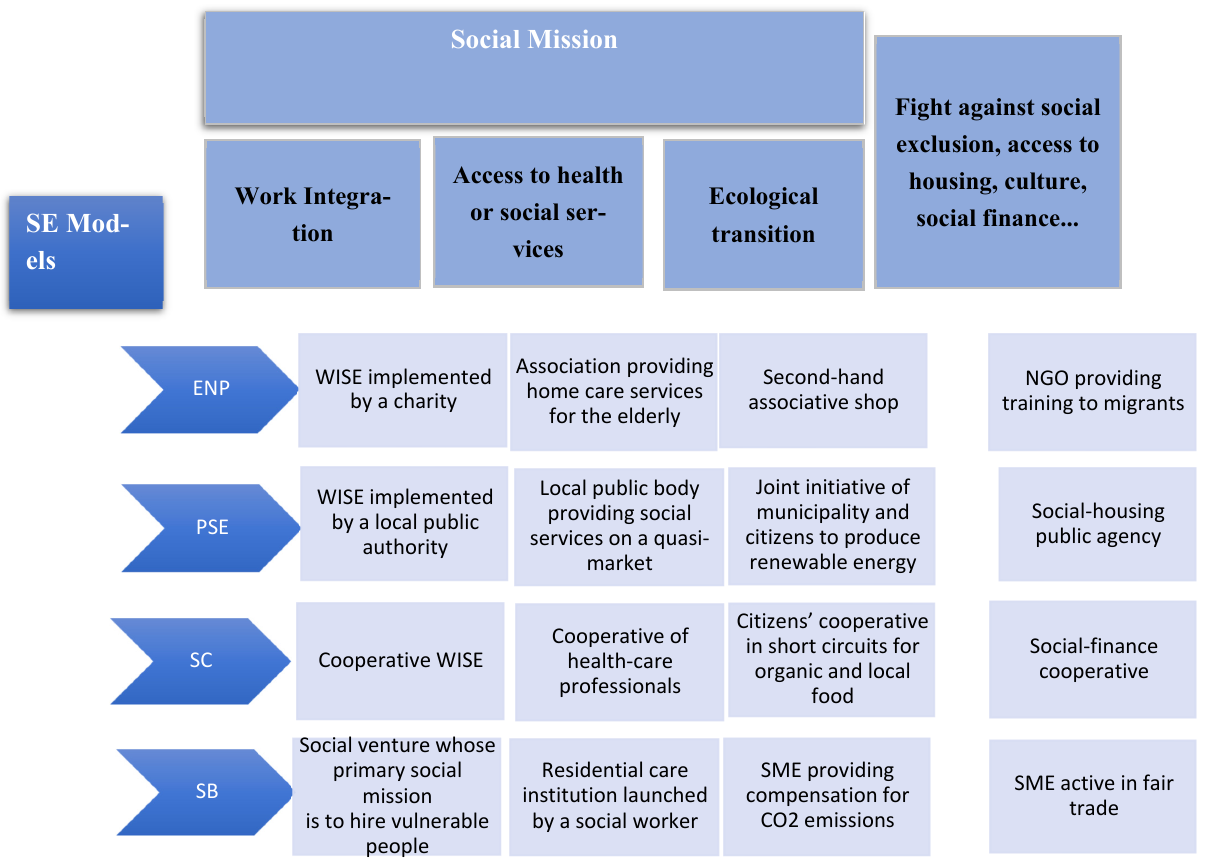
Figure 3. Social Enterprise Models and Social Mission. Source: Based on (Defourny et al. 2021). In Romania, for example, entrepreneurial nonprofit organizations, work integration social enterprises, and cooperatives (with general interest goals) are more common (Lam- bru and Petrescu 2021). While many countries have not yet adopted a special law for social enterprises, including Estonia and Georgia, in Latvia, the legal form—although strictly defined as SE—still allows a variety of activities, unlike Lithuania, where the law defines the concept so narrowly that many companies with social missions are not acknowledged as social enterprises (Evans et al. 2021).